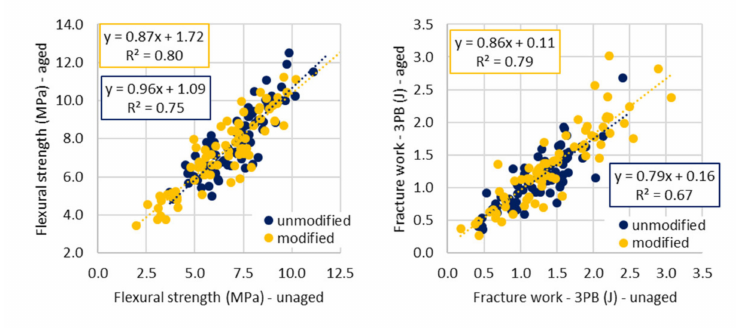
Figure 5. Comparison of aged and referential parameters for different groups of mixes—three-point bending test.